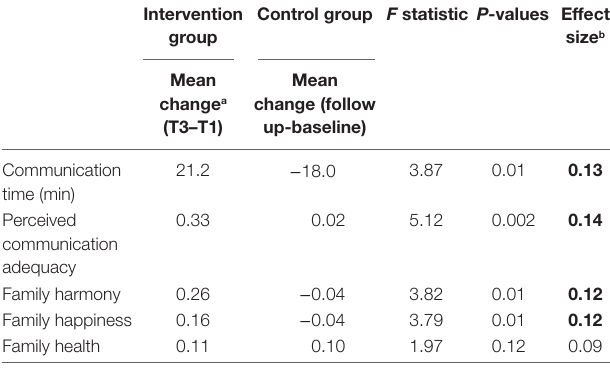
TaBle 3 | Differences in changes of family communication and family 3Hs between the intervention and control group.